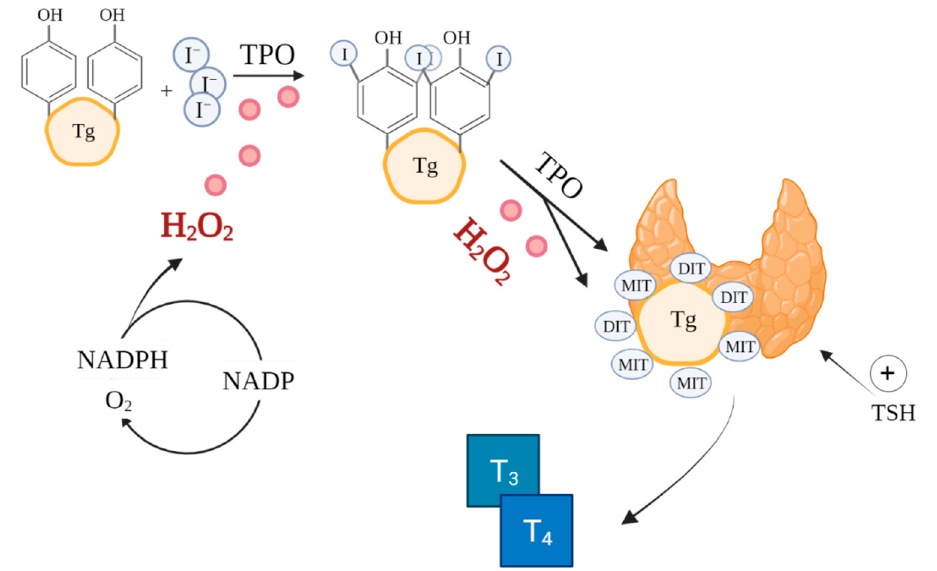
Figure 1. Role of ROS in thyroid hormones synthesis. Based on [47,56]. Created with BioRen- der.com.(accessed on 26/08/2021) I—iodine, TPO—thyroid peroxidase, Tg—thyroglobulin, MIT— monoiodotyrosine, DIT—diiodotyrosine, T 3 —triiodothyronine, T 4 —thyroxine.